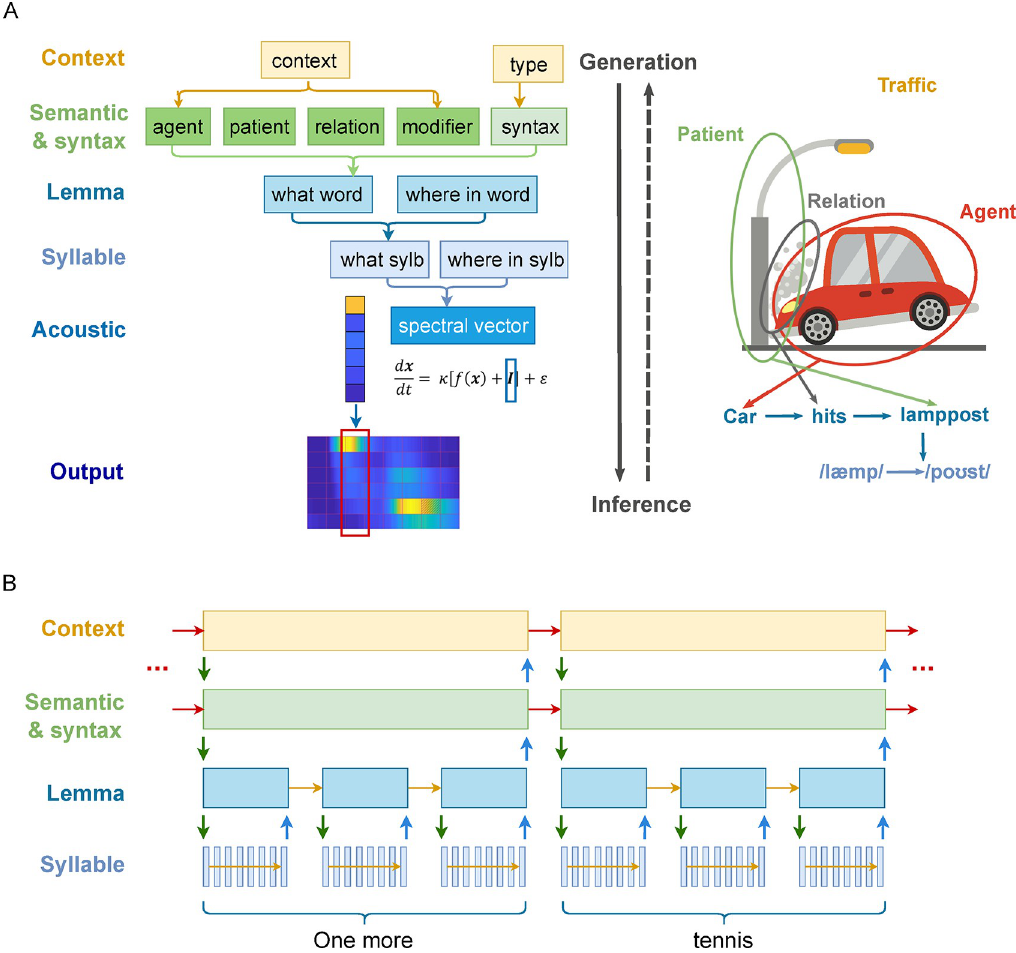
Fig 1. A generative model of speech and its inversion. ( A ) Schematic of the generative model . Left : Information conveyed in a speech signal is roughly separated into six hierarchies. To generate speech (solid downward arrow), the model first assigns values to semantic roles according to the contextual knowledge and determines a (linear) syntactic structure from the type of the message it is expressing. Together, semantics and syntax generate an ordered sequence of lemma units. Each lemma unit generates a sequence of syllables, which, in turn, generates a sequence of spectral vectors. Each spectral vector unit is then deployed as a continuous acoustic signal of 25 ms. Inference corresponds to the inversion of the generative process (dashed upward arrow). The model is divided into three parts that were implemented with different algorithms (see Methods). Right: Cartoon (www.publicdomainpictures.net) illustrating how a sequence of syllables ‘/læmp-po ʊ st/’ (lamppost) is generated from a traffic scene context. In describing a traffic accident, the speaker tries to convey its mental image of the scene consisting of an agent (the car), a patient (the lamppost), and the relation (the action of hitting) from the agent to the patient. With English vocabulary and grammar, it chooses one lemma corresponding to each element in the accident and outputs (speaks) these lemmas in a specific order according to the syntactic rules. Each lemma is then expressed as a specific sequence of syllables. Importantly, the same lemma can be the result of different combinations of abstract information and syntactic rules. For example, in the sentence “The ball hits the floor”, the word “hits” implies a different action than a car hitting a cyclist, whereas in “His songs are top hits”, the relative position of the word implies an entity, not an action. ( B ) Temporal scheduling of hierarchical message passing during speech perception. The generative model is inverted by alternating top-down prediction (prior, green downward arrows) and bottom-up update (blue upward arrows). A supraordinate level initiates a sequence of evidence accumulation in its subordinate level and receives a state update at the end of such sequence. It then makes a transition and sends an updated prediction to the subordinate level and initiates another sequence of evidence accumulation. Such a process is repeatedly performed until the end of the sentence. Note that for the lemma and lower levels, states are generated anew each time when the supraordinate level makes a transition, i.e., no horizontal arrows between sending up an update and receiving a new prior. For the top two levels, however, states are maintained throughout the sequence (red horizontal arrows) or make transitions according to a set of rules